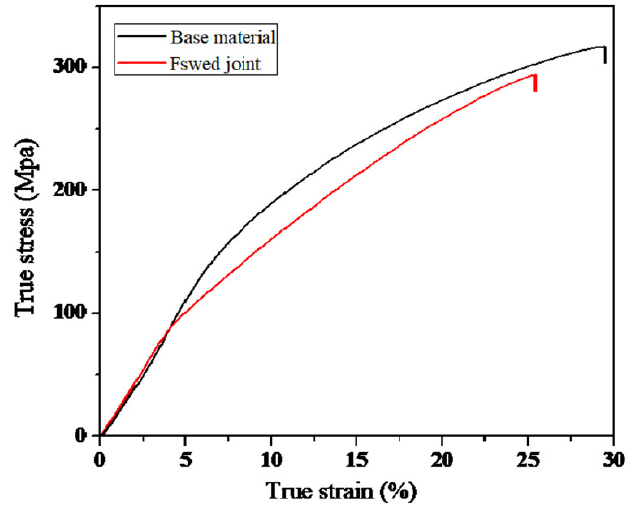
Figure 5. The true stress-strain curve.